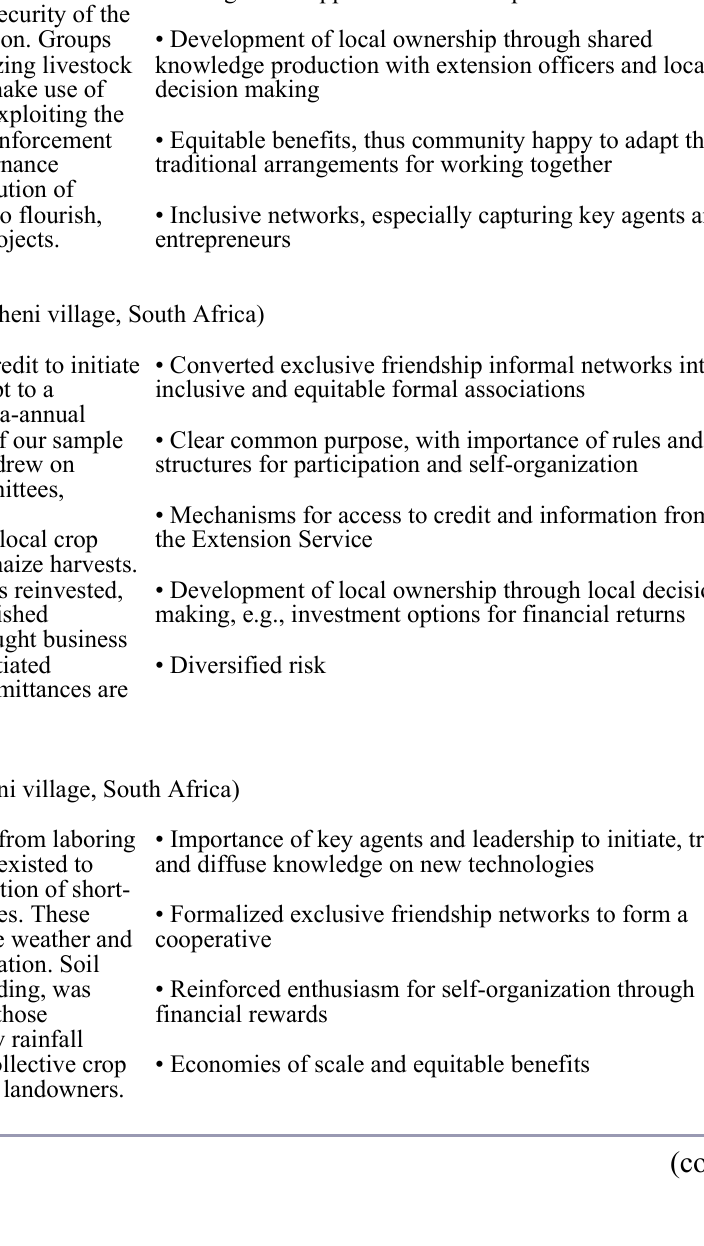
Table 4. Examples of successful collective